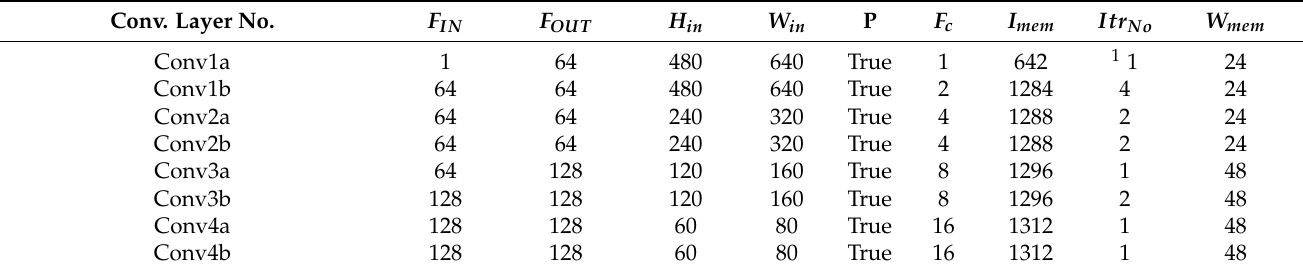
Table 3. Convolution layer parameters for input image and weights.